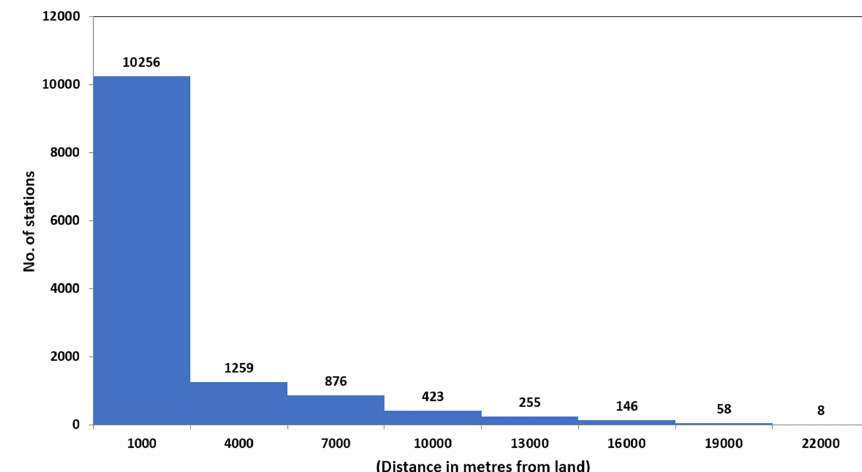
Figure 2. Histogram of the number of stations in each bin based on the distance in metres of each station from land.